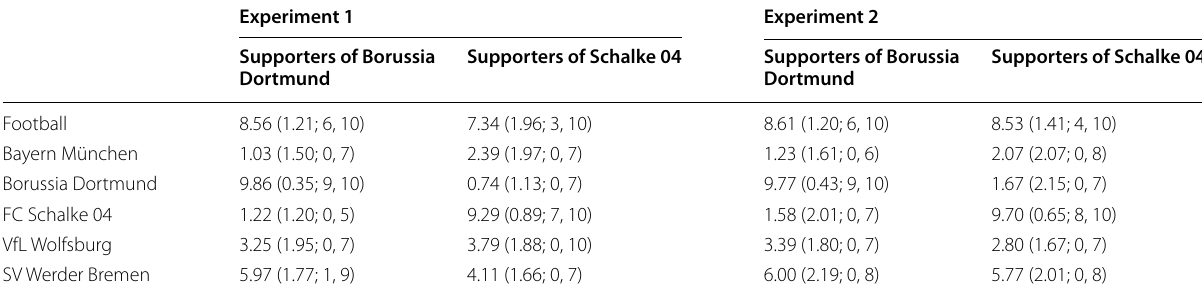
Table 1 Descriptive statistics (mean, standard deviation, minimum, and maximum) of the preference data observed in Experiments 1 and 2